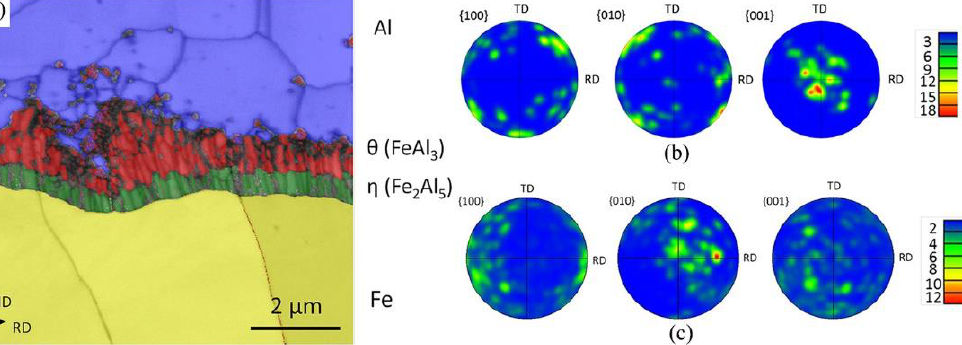
Figure 15. EBSD results at the welding interface between 6111 aluminum alloy and DC04 steel [44]: ( a ) the dual-phase IMC reaction layer; ( b ) pole figures of Fe 2 Al 5 phase; ( c ) pole figures of FeAl 3 phase.